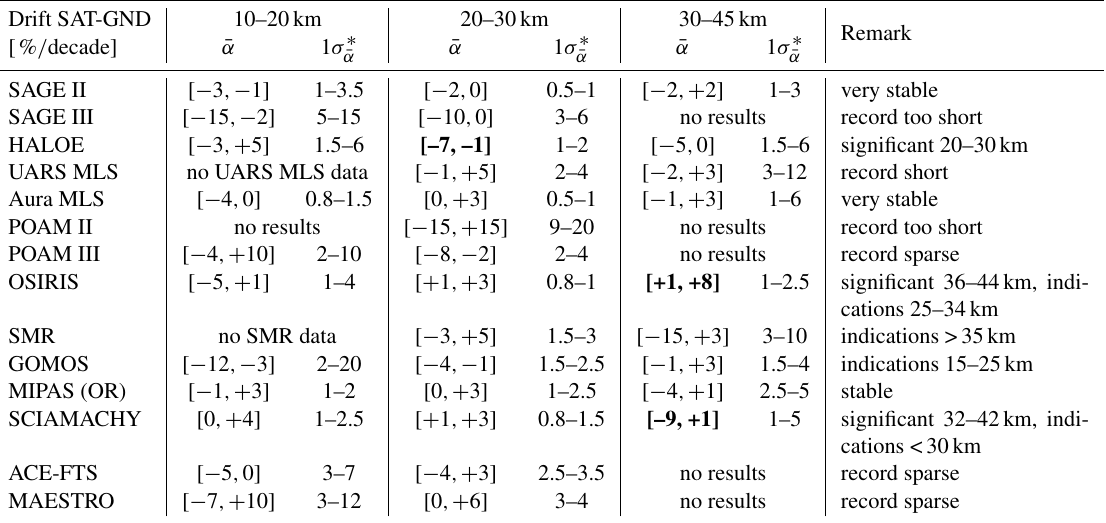
Table 4. Overview of the drift of satellite ozone profile records relative to ozonesonde and lidar, in the lower, middle and upper stratosphere. For each altitude region we present the range of the network average of the drift ( ¯ α ) and its adjusted one sigma uncertainty ( σ ∗ ¯ indicate results with more than 2 σ